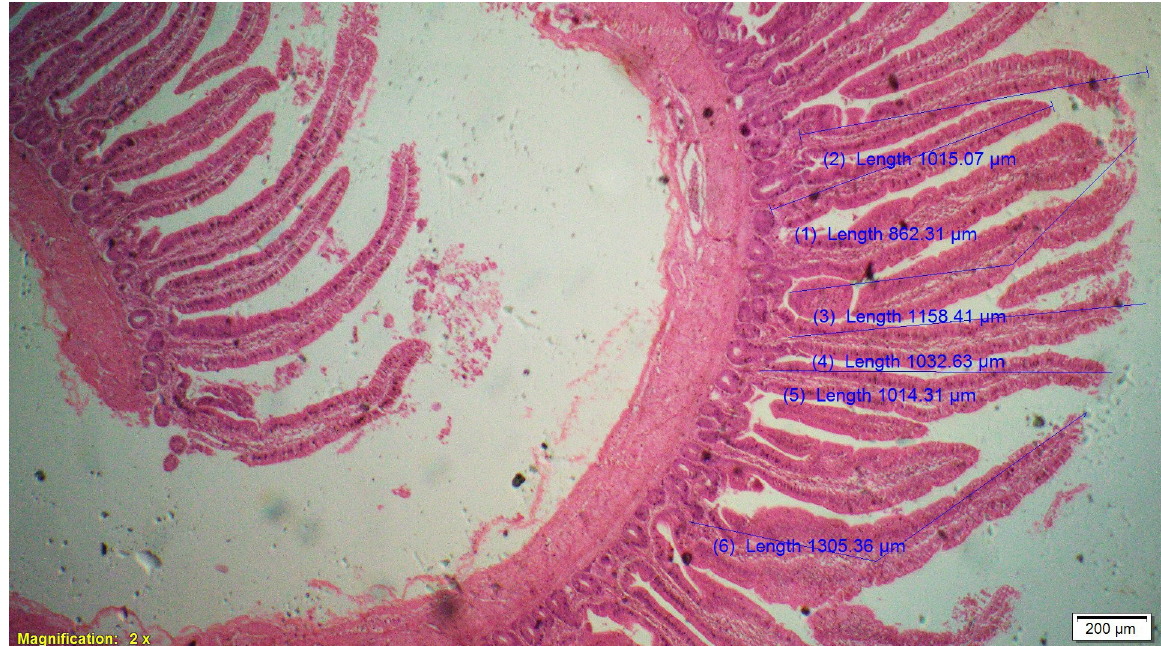
Fig 3. Photomicrograph of the cross section of Jejunum from probiotic + chicory group (T3), H&E, 2x.